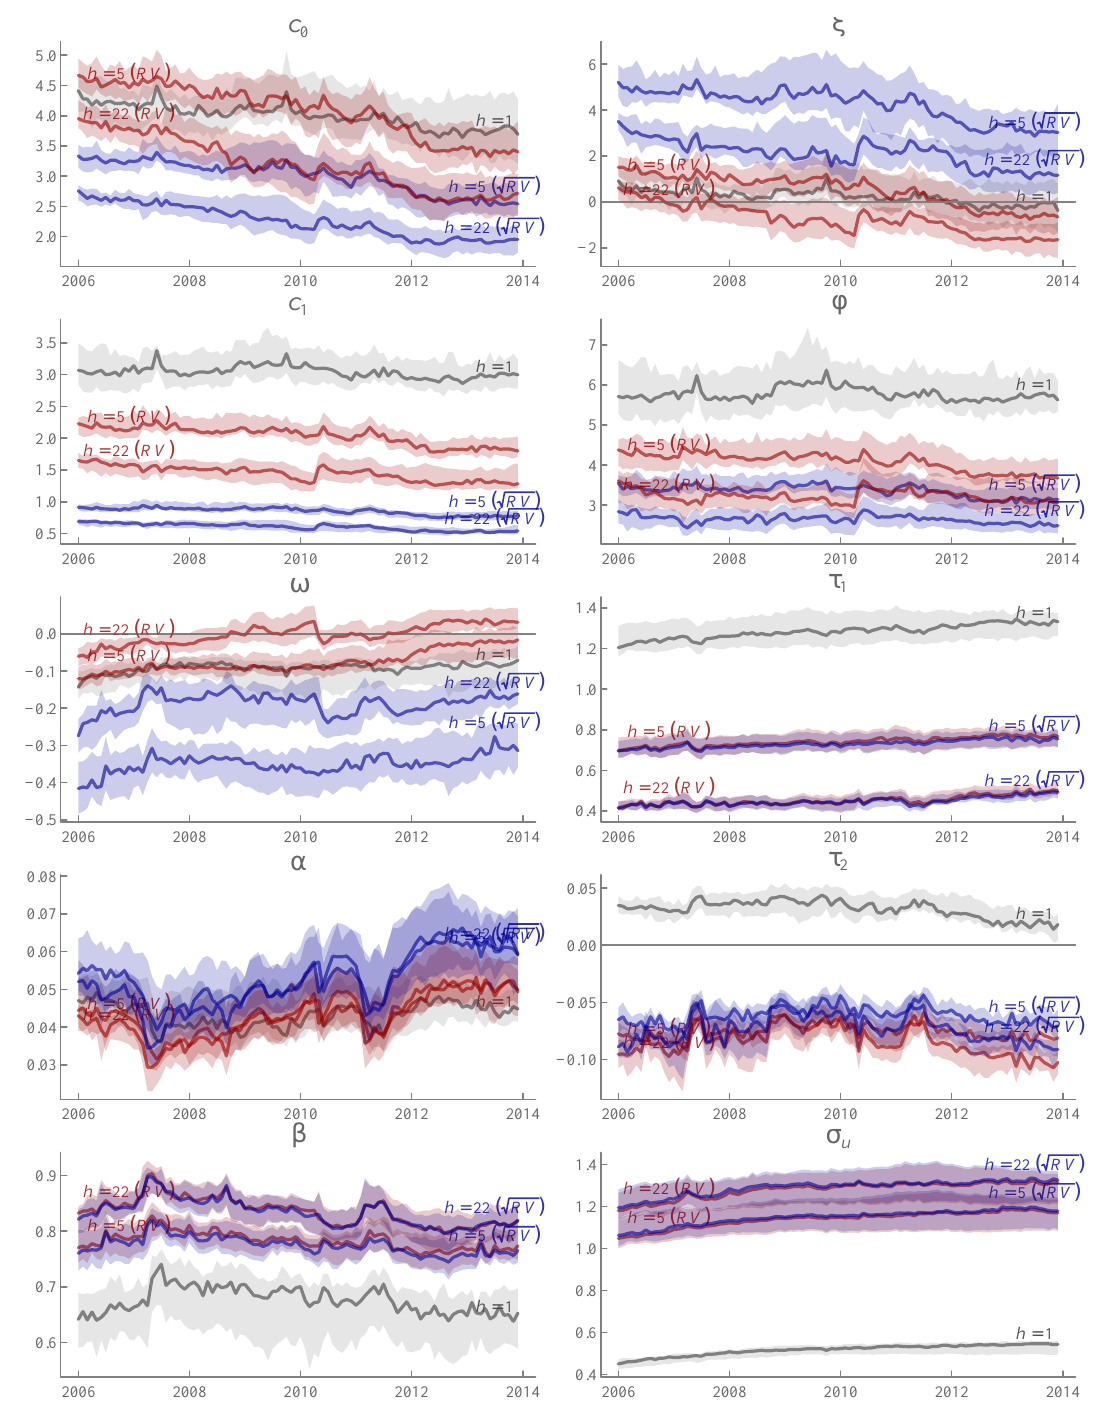
Figure 1. Rolling parameter estimates for log-in-mean specification (Section 3.1) for stepsizes h = 1,5, 22. For h > 1, two models are estimated, one using the log of the average of RV (red) and √ RV (blue). The shaded area is the interquartile range across the one with the log of the average of 27 stocks and the solid line is the median. The daily sample is from 22 April 1997 to 31 December 2013 (4200 trading days). The rolling estimation window is 8.67 years (104 months) followed by a one-month prediction window shifted each month over the sample for 96 estimation